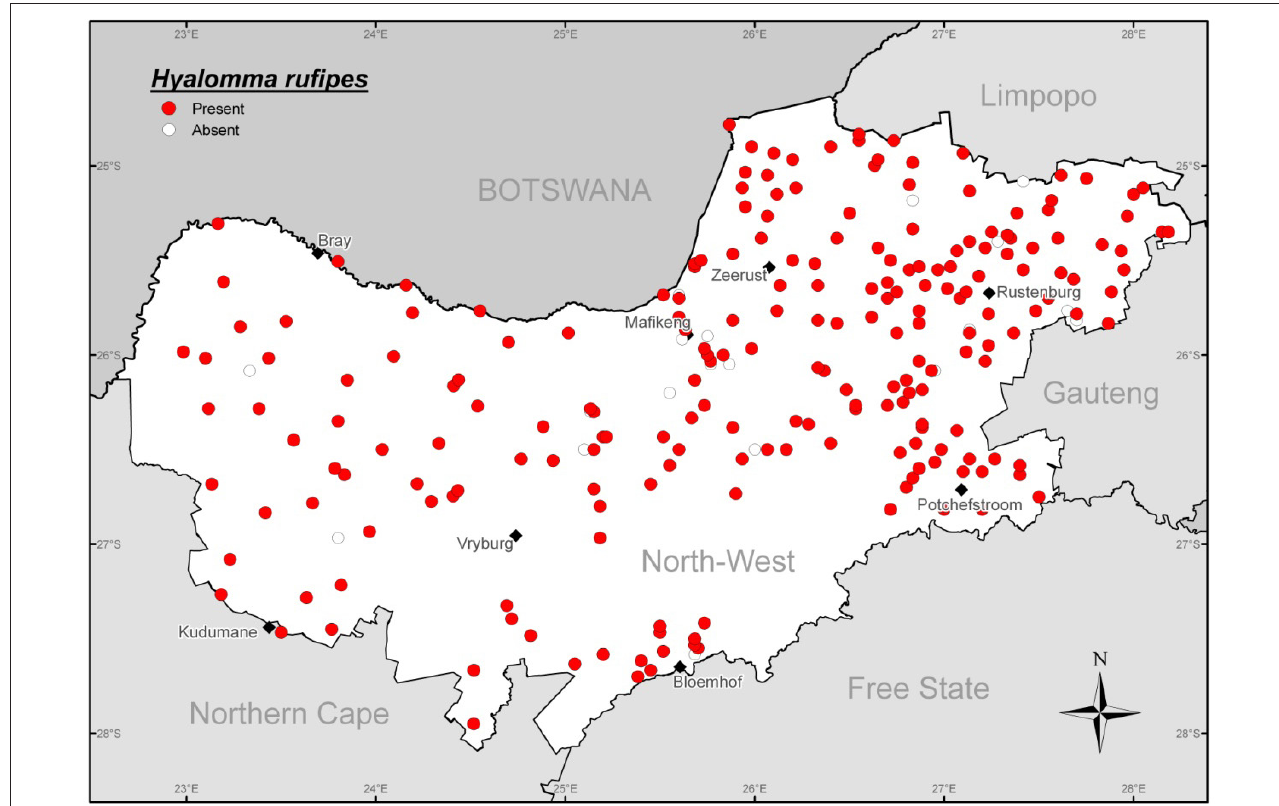
FIGURE 4: The geographic distribution of Hyalomma rufipes in the North West province, South Africa.